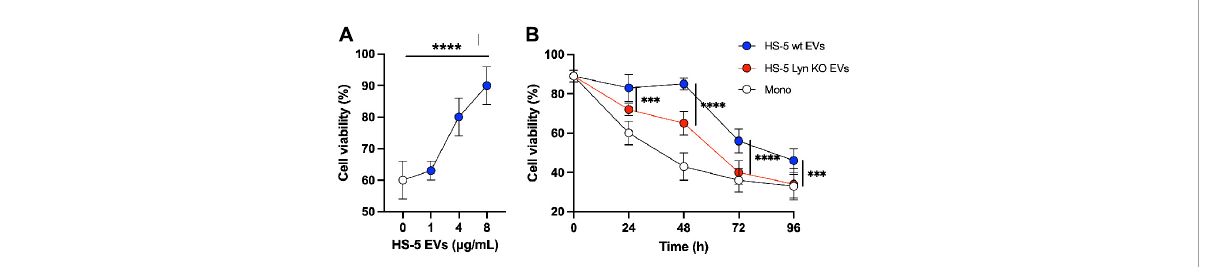
FIGURE5 Lyn contributes to generate chronic lymphocytic leukemia (CLL)-supportive extracellular vesicles (EVs). (A) Primary CLL cells (0.3 × 10 6 / well in a 96-well plate) of 11 different donors were cultivated in RPMI-1640 medium with 10% FBS and a dilution series of purified EVs from HS-5 cells as indicated. After 24 h the cell viability was determined with CellTiter-Glo 2.0. Statistics: Brown–Forsythe ANOVA test. (B) The differential effect of EVs (4 µ g/ml) from Lyn-proficient and -deficient HS-5 cells on the viability of primary CLL cells was compared with untreated CLL cells in a kinetic study (0–96 h). At the end of the indicated incubation period, the cell viability was determined with CellTiter-Glo 2.0. Statistics: two-tailed, unpaired t -test with Welch’s correction at indicated time points ( ∗∗∗ P < 0.001, ∗∗∗∗ P <